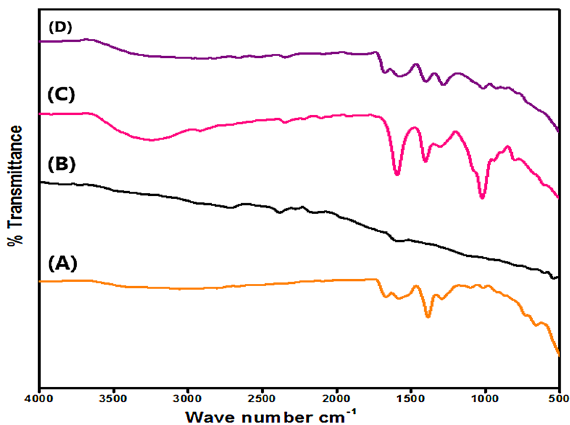
Figure 3. FTIR spectra of ( A ) MIL-125(Ti)/MIL-53(Fe) binary MOF, ( B ) CNT, ( C ) alginate and ( D ) MIL- 125(Ti)/MIL-53(Fe)/CNT@Alg composite microbeads.